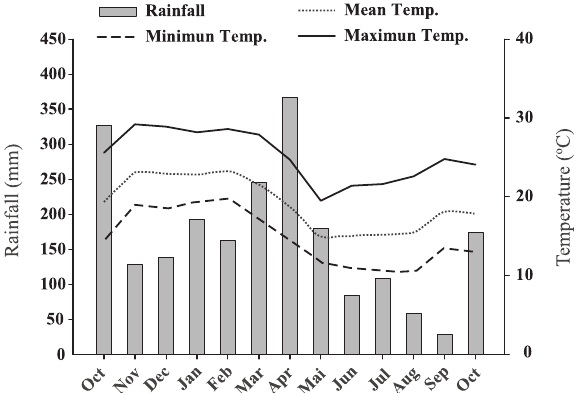
Figure 1. average, minimum and maximum temperatures and rainfall data during the experimental period of 2009/2010 (iaPar, 2011).